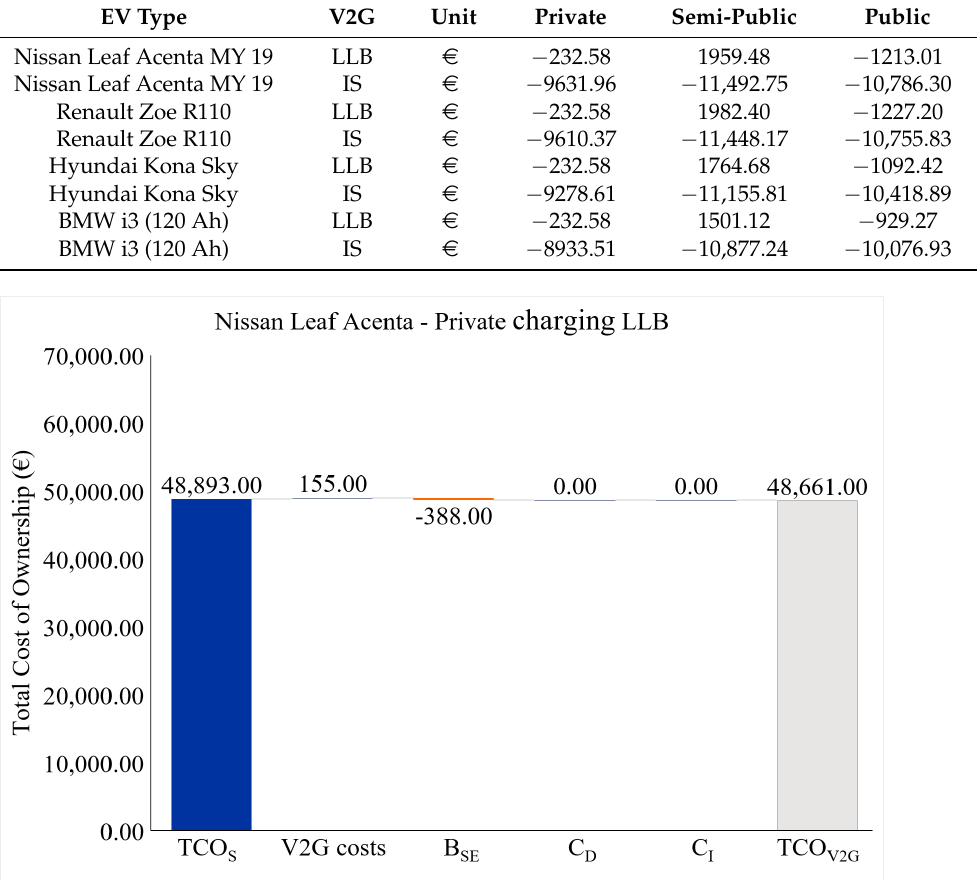
Figure 7. Standard and V2G TCO of a Nissan Leaf charged at a private charging case providing LLB ( TCO S = Standard TCO, B SE = benefit of saved electricity costs from the grid, C D = direct compensation, C I = indirect compensation, TCO V 2 G = V2G TCO; source: own